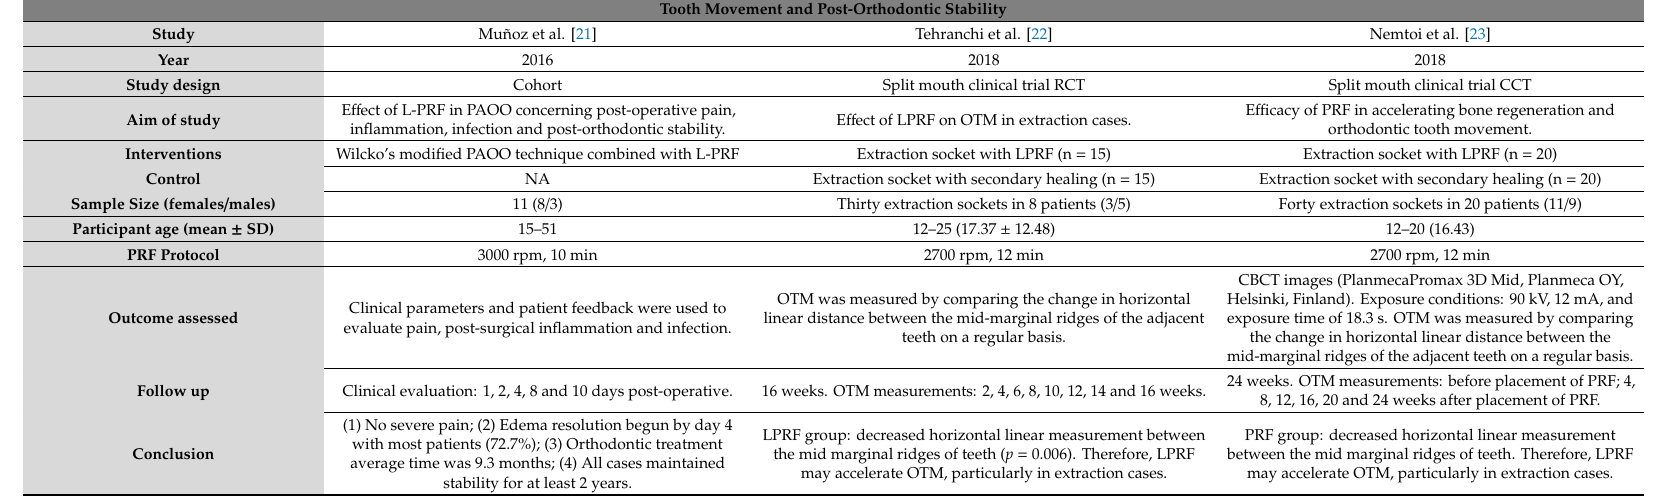
Table 3. Characteristics of included studies on tooth movement and post-orthodontic